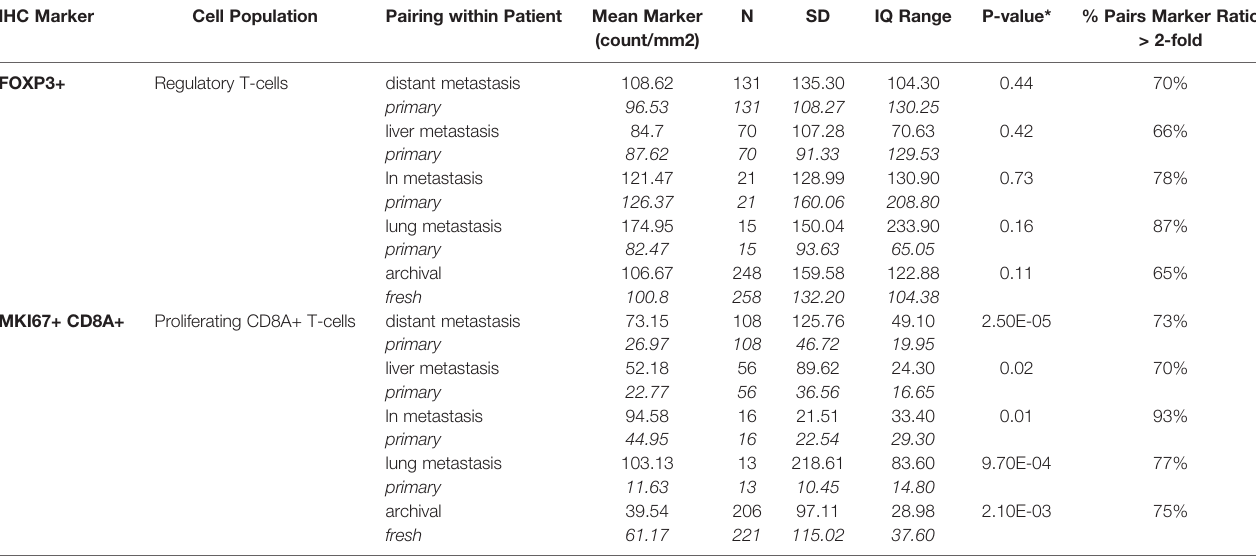
TABLE 2 | Paired t-tests by tissue type and lesion